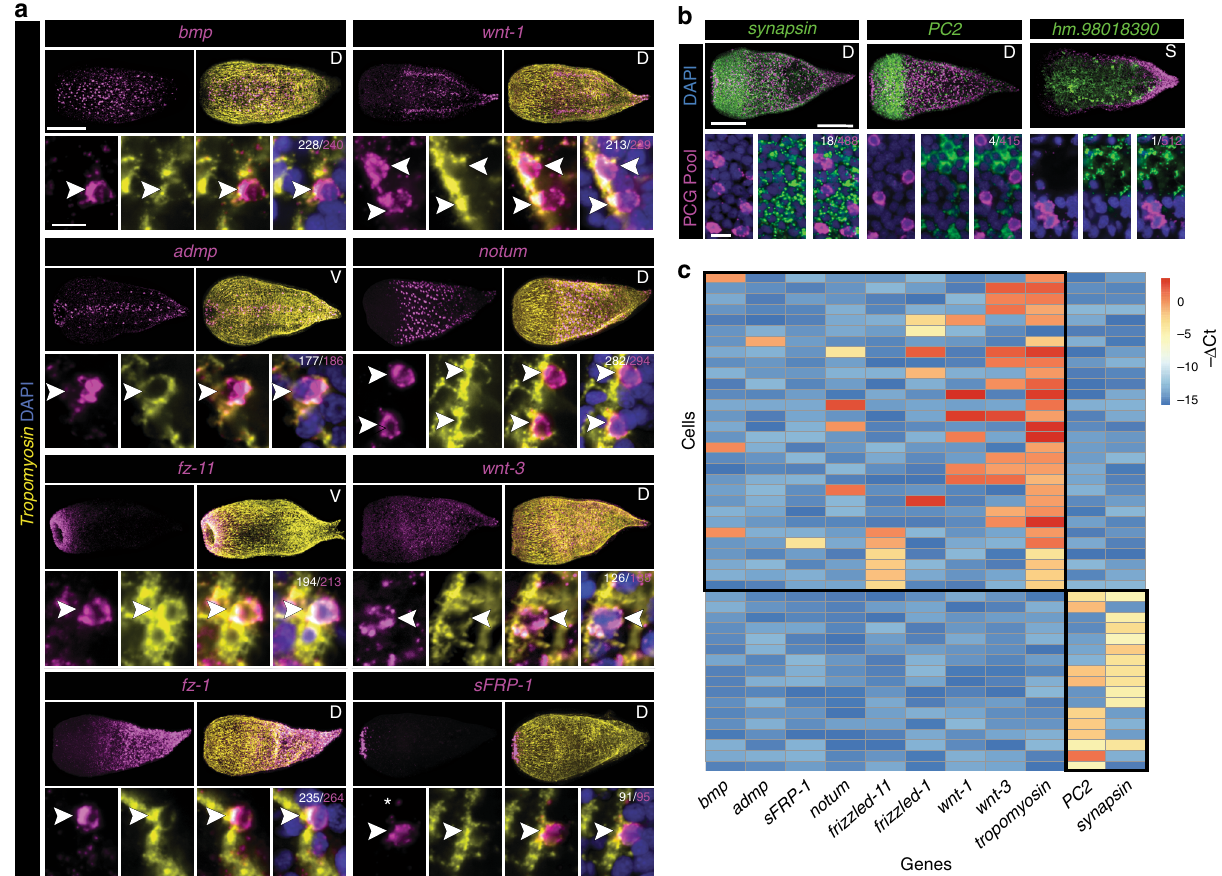
Fig. 2 Muscle speci fi cally harbors positional information in Hofstenia . a PCG( + ) cells also expressed tropomyosin . Both muscle fi bers and nuclei are marked by tropomyosin mRNA; PCG mRNA is localized primarily around the nucleus. Denominator for each quanti fi cation is the total number of PCG-positive cells; the numerator is the total number of PCG/ tropomyosin double-positive cells. Asterisk denotes fi ber expression of PCG. b PCGs were not signi fi cantly expressed in PC2 - or synapsin -positive neuron populations, nor in an internal differentiated cell population marked by expression of hm.98018390 . The PCG RNA probe pool was the same as in Fig. 1c. c Single-cell cDNA libraries were screened by qRT-PCR with primers speci fi c to PCGs, tissue-type markers ( tropomyosin, PC2 , and synapsin ), and a housekeeping gene GAPDH . Any cell without expression of GAPDH was excluded from the analysis. Shown are all remaining cells positive for at least one PCG and/or positive for at least one neural marker. − Δ Ct = − [Ct(gene of interest) − Ct( GAPDH )]. All Ct values greater than 32 or undetected were analyzed as Ct = 32. 29/30 PCG-positive cells also expressed tropomyosin . 0/30 PCG-positive cells expressed the neural markers PC2 or synapsin . tropomyosin expression was never found in single-cell libraries with expression of either neural marker, indicating that our libraries were indeed ampli fi ed from single cells. Scale bars: a , b 100 μ m, overview image; 10 μ m, cell inset. D dorsal view, V ventral view, L lateral view, S coronal section. Overview images are representative of 5/5 animals receptors, and secreted antagonists (e.g., secreted frizzled-related protein, sFRP, or the secreted Wnt deacylase Notum 26, 27 ) are regionally expressed along the Hofstenia anterior – posterior (AP) axis 17 . Perturbation of several Wnt pathway components resulted in abnormal AP patterning in regeneration 17 . For instance, RNAi of the posteriorly expressed wnt-1 gene resulted in regeneration of a head in place of a tail, generating two-headed acoels, whereas RNAi of the Wnt-antagonist notum resulted in two-tailed acoels. Genes encoding several Bmp pathway components, including Bmp-family signaling ligands, are expressed in different patterns on the dorsal – ventral (DV) and medial – lateral (ML) axes 17 .